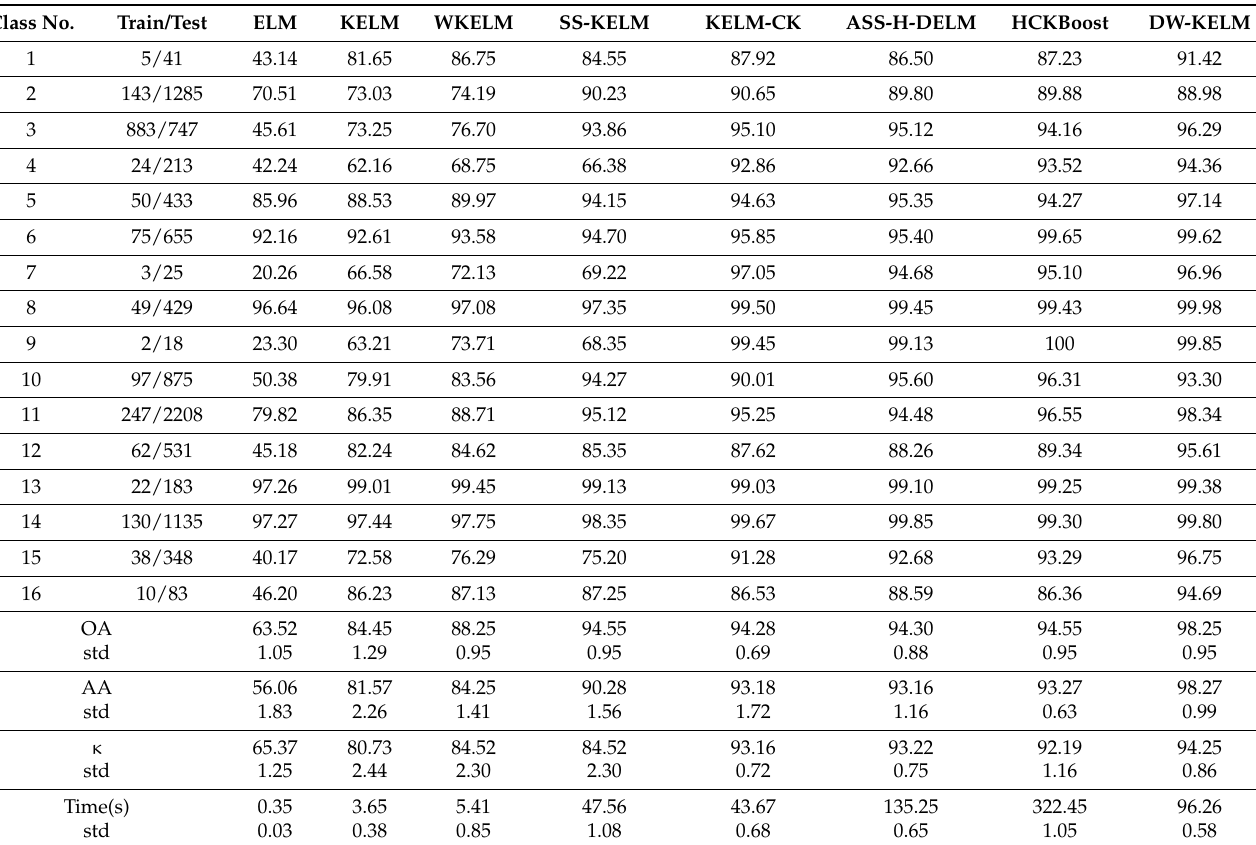
Table 1. Overall accuracy (OA), average accuracy (AA), and kappa (%) obtained by different approaches on the Indian Pines data